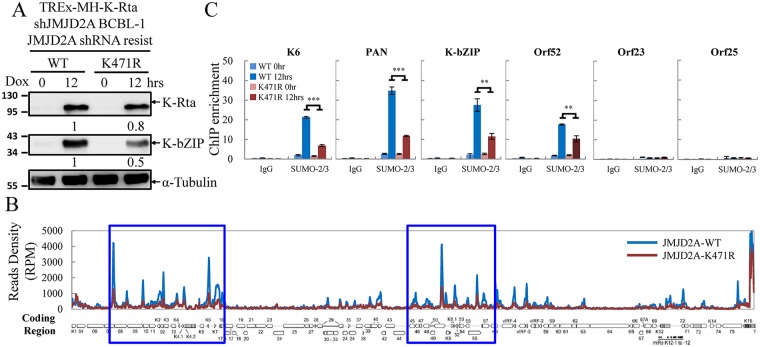
JMJD2A SUMOylation is crucial for SUMO-2/3 enrichment on the KSHV genome during viral reactivation.(A) TCLs from TREx-MH-K-Rta-shJMJD2A-Flag-JMJD2A-WT and -K471R BCBL-1 cells before and after 12 hrs Dox (0.2 μg/ml) treatment were immunoblotted with antibodies as indicated. Ratio is the relative signal of K-Rta or K-bZIP to α-Tubulin observed for Dox treatment at 24 hrs using TREx-MH-K-Rta-shJMJD2A-Flag-JMJD2A-WT BCBL-1 cells as 1.0. (B) ChIP-seq assay was performed with chromatin from cells treated as described in (A) using rabbit IgG and anti-SUMO-2/3 antibodies. Sequenced reads mapped to KSHV genome were normalized with total reads from the human genome. The histogram shows reads per million mapped reads (RPM) mapped across the KHSV genome (JMJD2A-WT, blue; -K471R, red). p = 2.27e-103 by Student’s-t test. The blue rectangles are high SUMO-2/3 regions as in Fig 1A. (C) ChIP-seq data was verified by real-time qPCR using primer pairs specific for promoter regions of KSHV K6, PAN, K-bZIP, Orf52, Orf23 and Orf25. (Data represent mean±SEM. n = 3. **p<0.01. ***p<0.005).